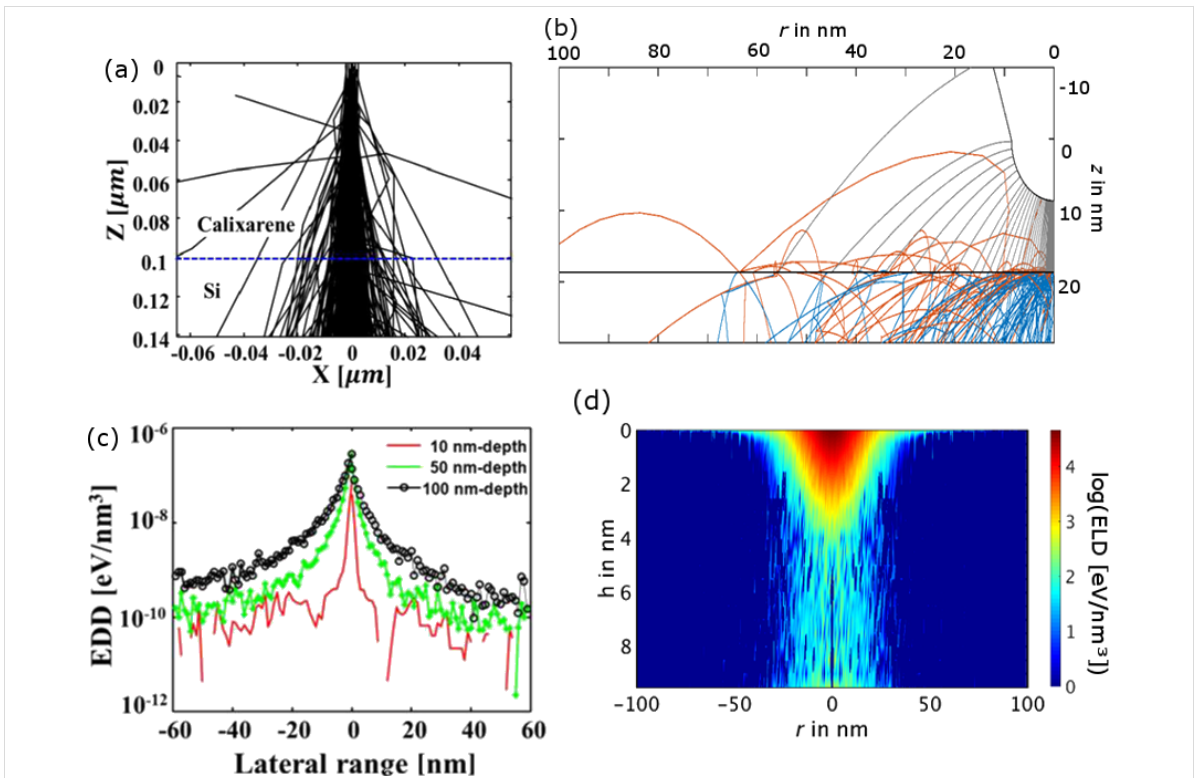
Figure 22: (a) Electron trajectories for 30 keV EBL exposure of 100 nm calixarene film on a Si sample. (b) Electron trajectories for FE-eSPL with 50V tip bias, 10 nm tip–resist distance and 10 nm thick calixarene resist (note that only one half of the tip and simulation area is shown). (c) Deposited energy distribution (EDD), describing the energy transferred from the electrons into the resist due to inelastic scattering, shown for various depths inside the resist for 30 keV EBL exposure of 100 nm calixarene film on a Si sample, for calculation details see [177]. (d) Energy loss distribution (ELD), describing the energy lost by the electrons due to inelastic scattering events, for 50 eV FE-eSPL exposure of 10 nm thick calixarene resist (note that the calculation differs from the EDD, thus giving different absolute values). (a, c) Images reproduced with permission through Creative Commons Attribution (CC BY) from [177], 2013 SciencePG; (b, d) images reproduced with permission from